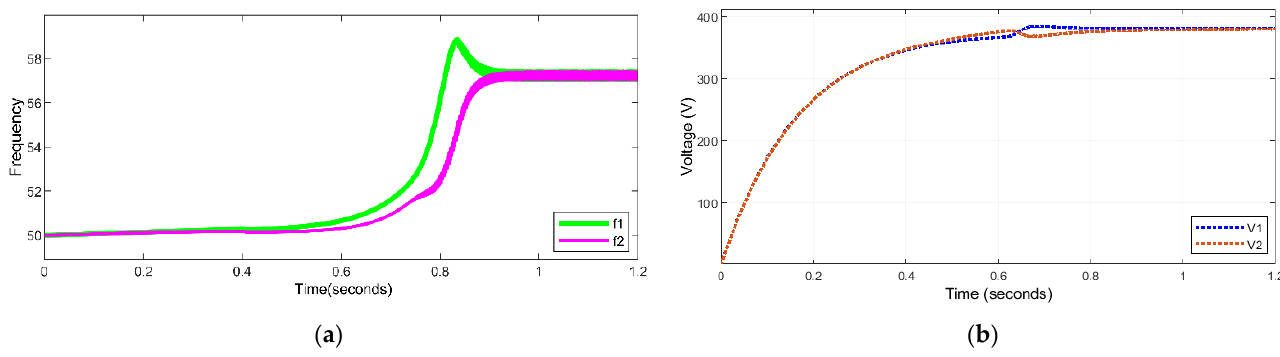
Figure 10. The controller adjusts some parameters and performance to optimize and stabilize the